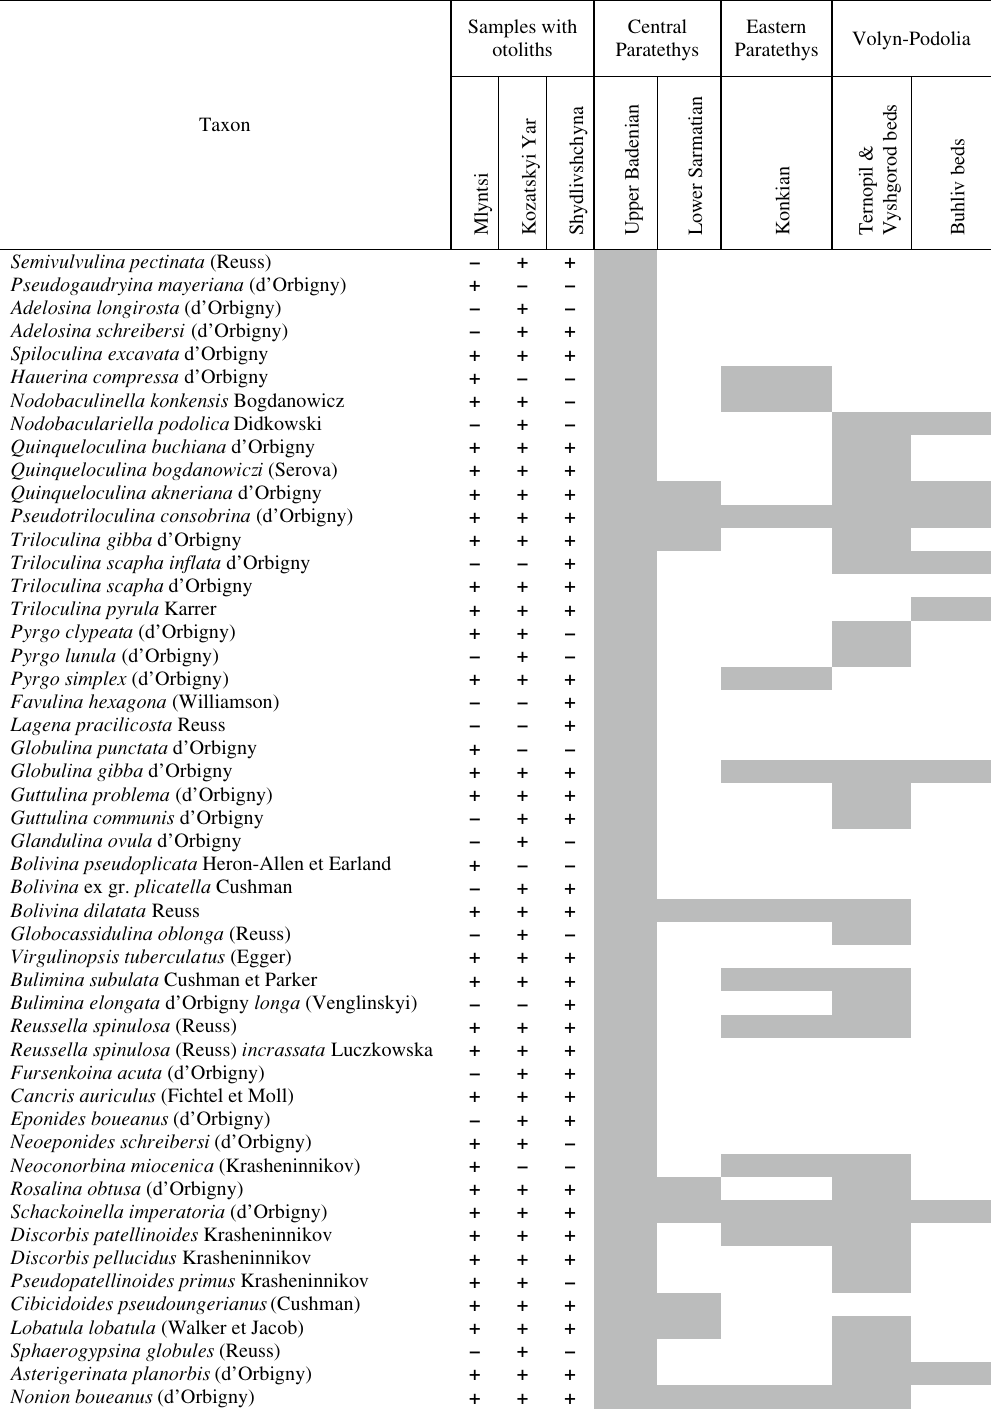
Table 1 List of foraminifera species identified in the samples of the rocks that yielded the described otoliths and comparison with coeval strata from other regions in the Paratethys—shading indicates regional occurrences of taxa outside of the sampled locations